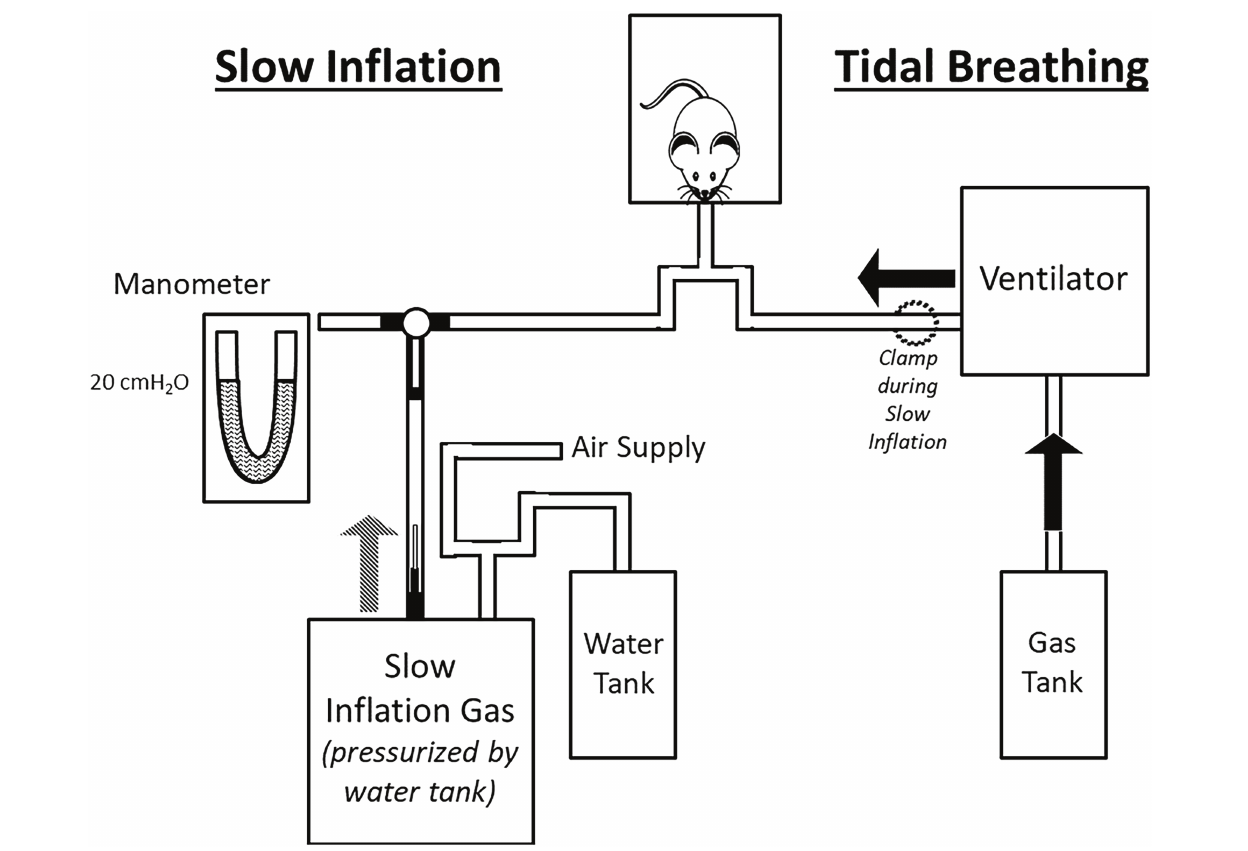
FIGURE 1 | Schematic of experimental set-up (not to scale). The experimental set-up comprised two circuits: one used during tidal breathing (right side) and one for slow inflation (left side) . Tidal Breathing : ventilation was achieved via a volume-ventilator supplied with experimental gas mixture. The slow inflation components were excluded from the circuit during tidal breathing by closure of a 3-way stopcock (see black T-shaped connection between manometer/slow inflation gas/animal). Slow Inflation : During slow inflation, the ventilator was turned off and the line to the animal clamped. Rotation of the stopcock connected the slow inflation system to the animal. The lungs were inflated slowly to the desired pressure set by the drum of compressed air, which was calibrated via manometer prior to the